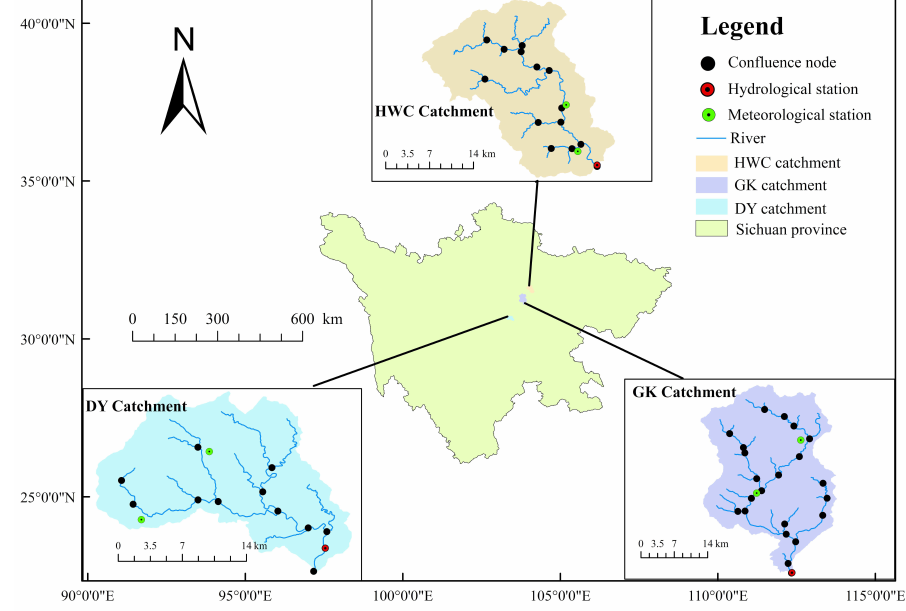
Figure 2. The Dayi (DY), Guankou (GK), and Hanwangchang (HWC)